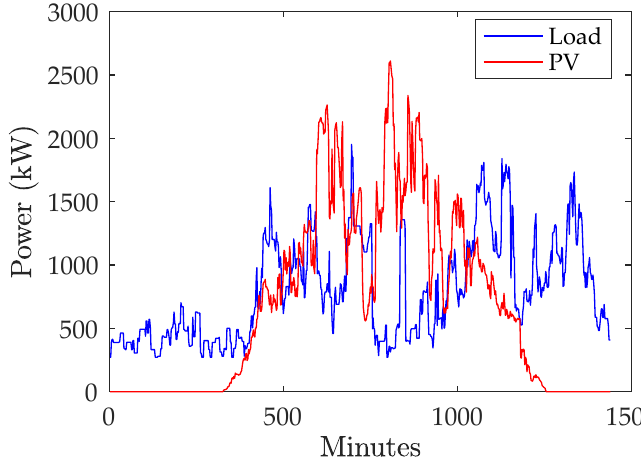
Figure 12. Total load power and PV generated power.